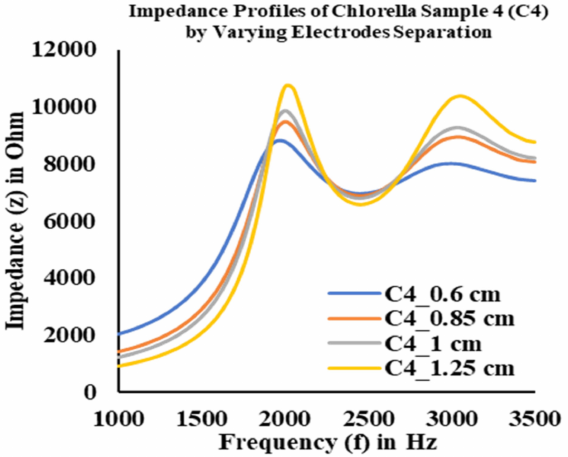
Figure 3. EIS measurements of a Chlorella sample (C4) by varying the distance between two electrodes from 0.6 to 1.25 cm. The impedance increases with the increase in the separation of the electrodes and the optimized distance was set to 1